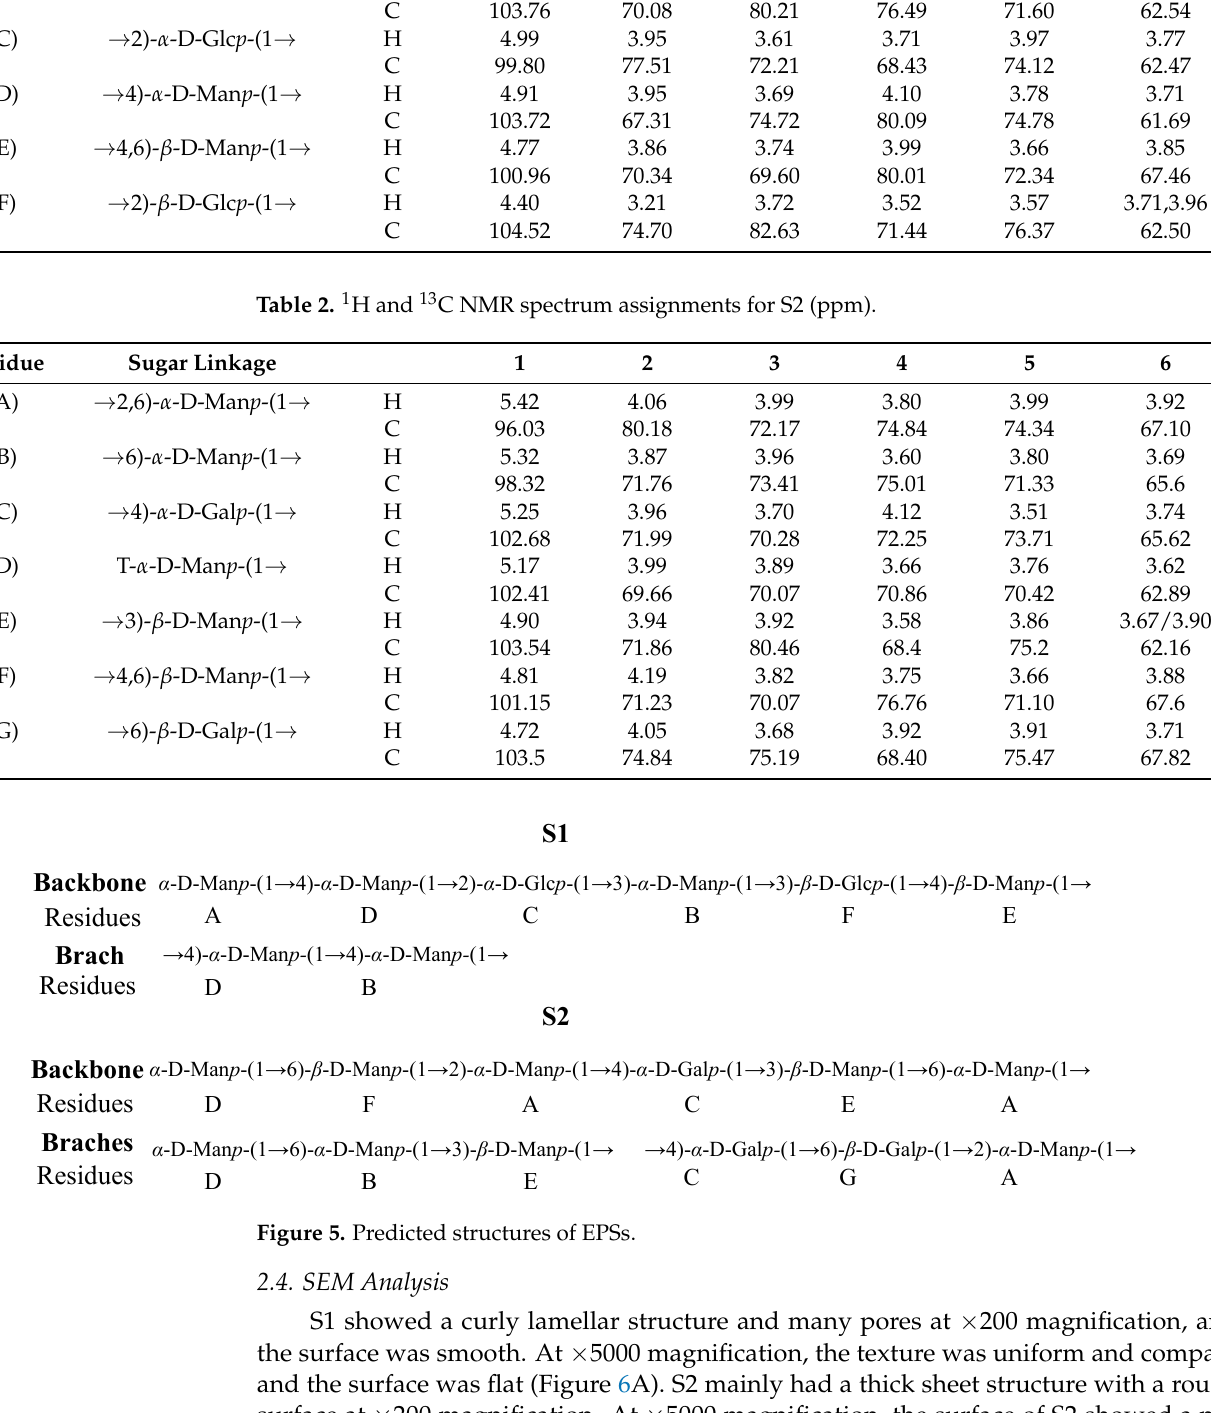
Table 2. 1 H and 13 C NMR spectrum assignments for S2 (ppm).